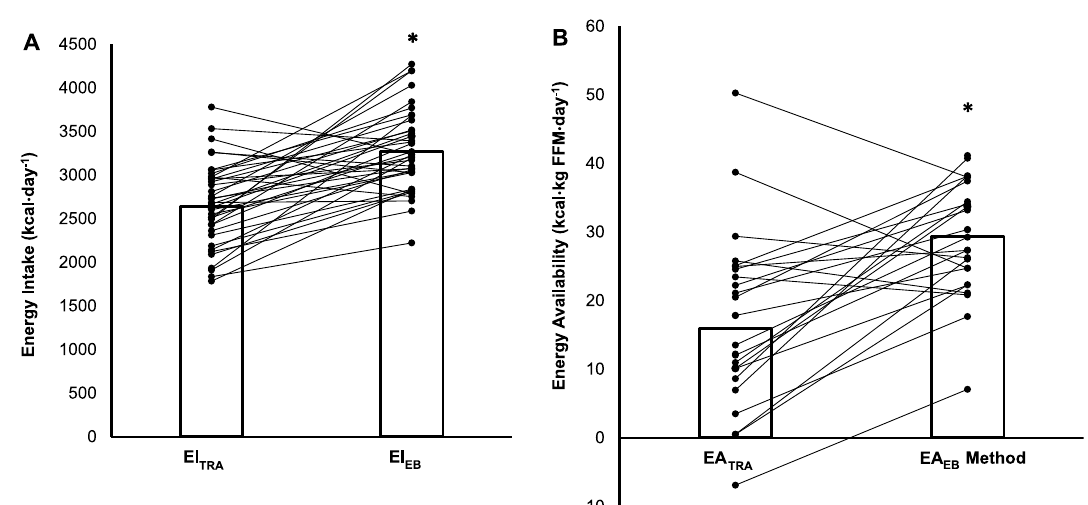
Fig. 2 Energy Intake ( A ) and Energy Availability ( B ) calculated traditionally and objectively. Data are for N displayed as means and individual data points. *Denotes significantly different (P < 0.05). EI TRA traditional energy intake method, EI EB energy